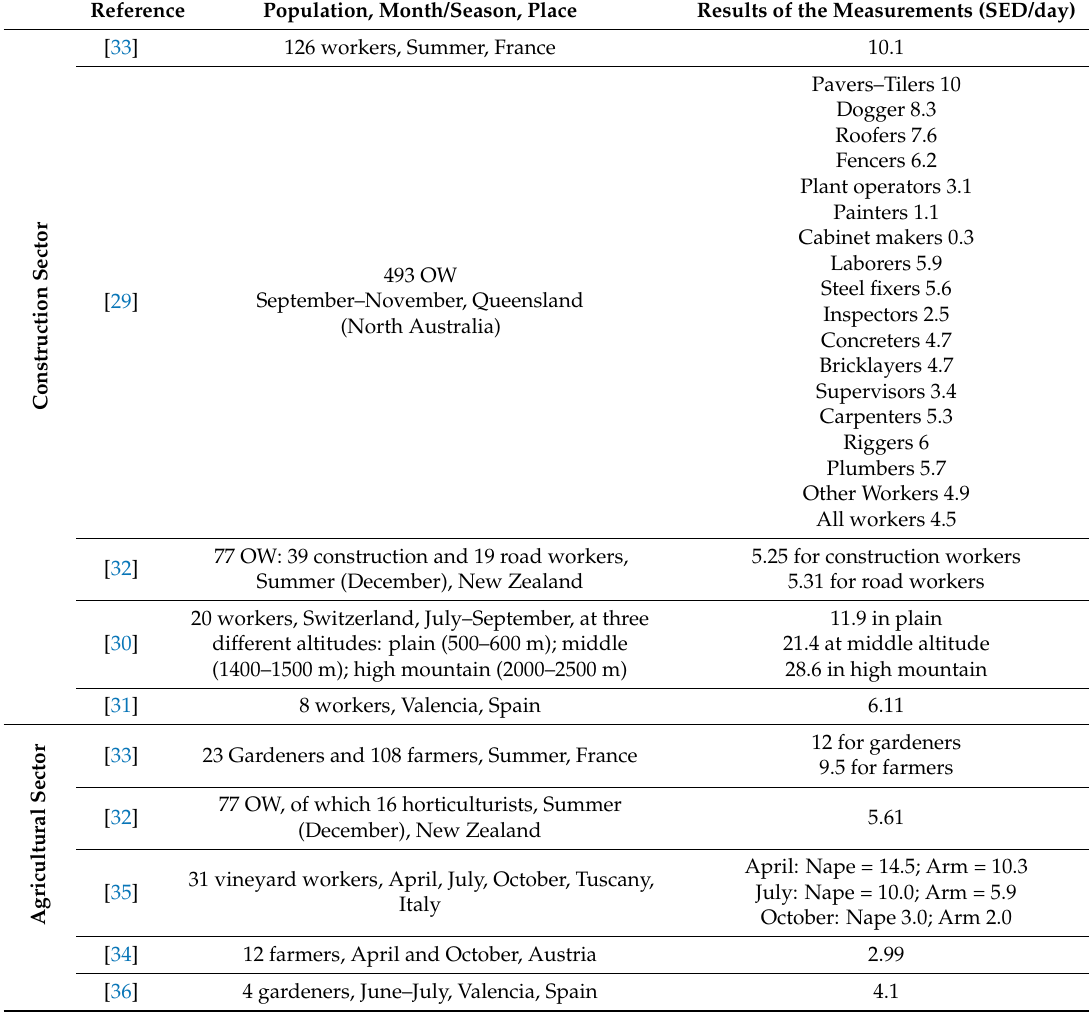
Table 1. Direct measurements of solar ultraviolet (UV) exposure in groups of outdoor workers in different sectors. Results of the measurements are in Standard Erythemal Doses (SED) per